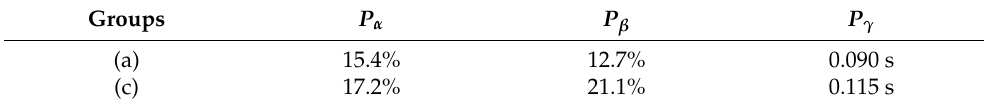
Table 11. Calculation results of the accuracy parameters of Figure 11.